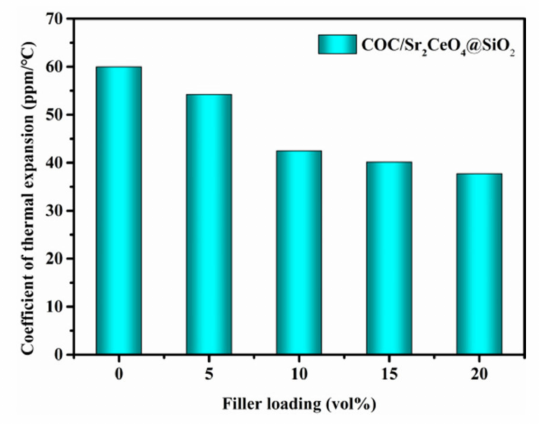
Figure 10. The coefficient of thermal expansion of COC/Sr 2 CeO 4 @SiO 2 composites.